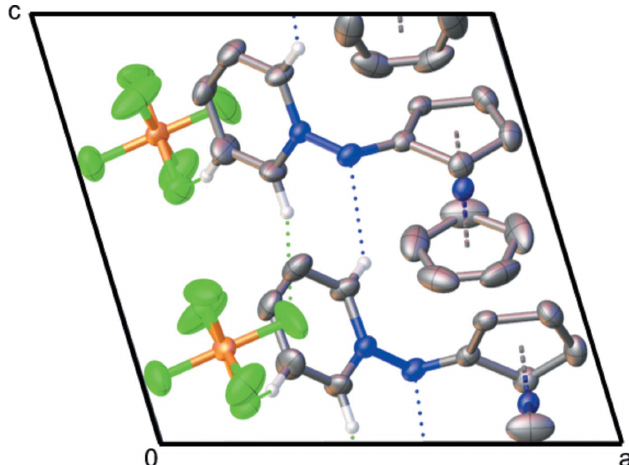
Figure 2 The arrangement of the molecular units of the title compound in the unit cell, with displacement ellipsoids drawn at the 50% probability level for non-H atoms along the b axis. Hydrogen bonds are represented by dashed lines (H (cid:5)(cid:5)(cid:5) N blue, H (cid:5)(cid:5)(cid:5) F green). Hydrogen atoms not involved in hydrogen bonds are omitted for clarity. (Symmetry code: x , (cid:4) y , z + 1